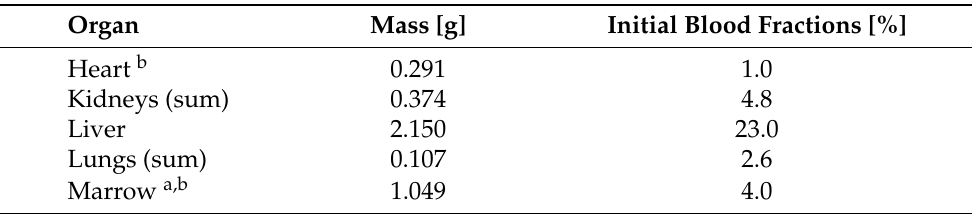
Table 2. Employed organ masses for scaling activity concentrations [%/g] into absolute activities [%], and theoretical blood fractions. Masses and blood fractions were taken from [32,33], except for: a mass from [34], and b same blood fraction as for the humans, taken from